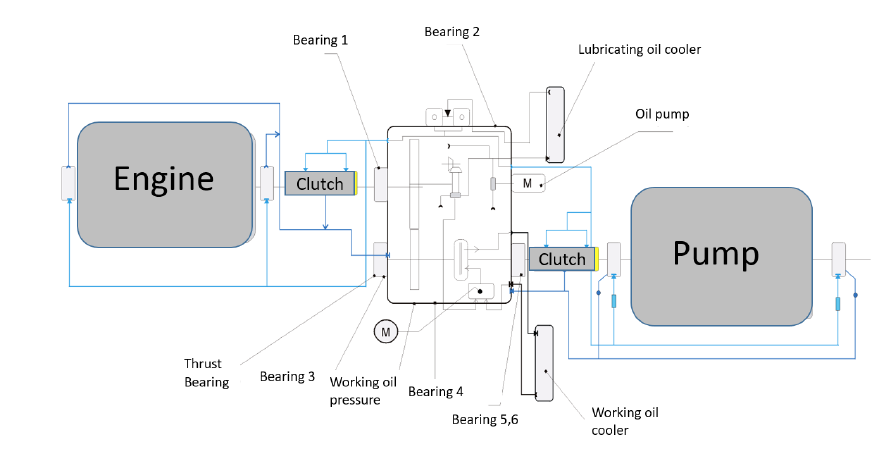
Figure 1. Schema of three stage pump